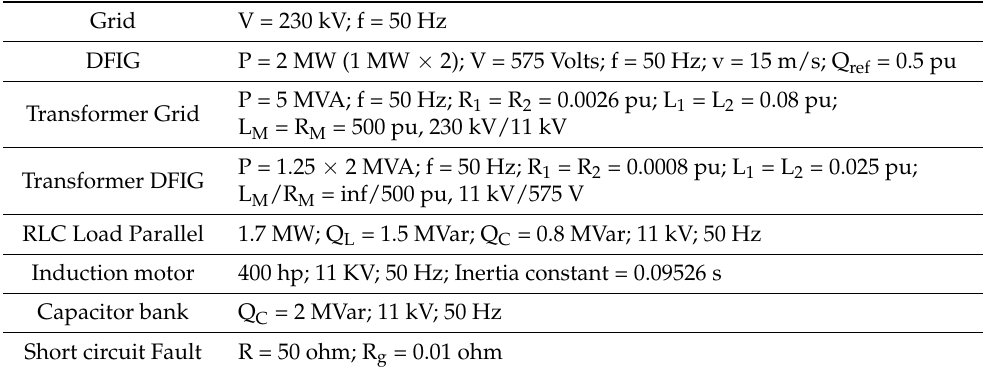
Figure 1. IEEE 1547 Generic test system. Table 1. Parameters for Simulation.